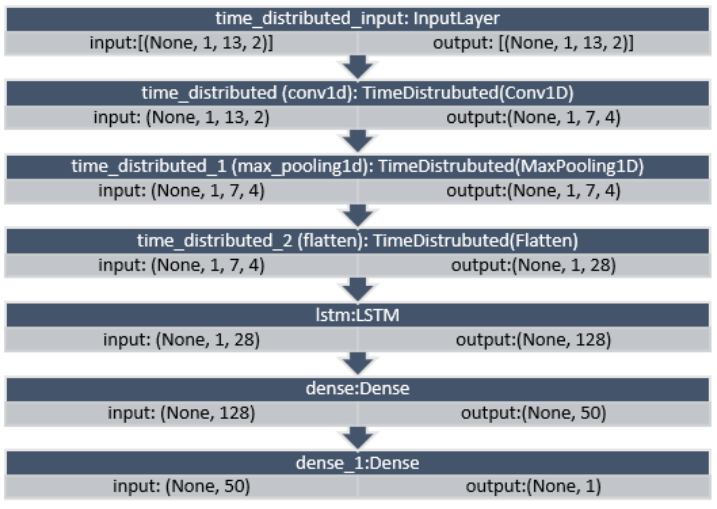
Figure 11. CNN–LSTM layers for the seventh iteration with (d0, o1) for the Beijing dataset. Figure 11. CNN – LSTM layers for the seventh iteration with (d0, o1) for the Beijing dataset. As for parameters, CNN had three layers: 1.—Conv1D with a dilation rate of 6 and group 2 with 4 filters and a kernel size of 2; 2.—the maximum pooling layer had a size of 1; 3.—the flatten layer. LSTM was composed of three consecutive layers: 1.—an entry layer (128 nodes); 2.—a hidden intermediate layer (50 nodes); and 3.—a final layer (one node). LSTM used tanh as an activation function and utilised the adaptive moment estimation (Adam) optimiser to minimise the loss function (MAE) and a batch size of (72) with (25) epochs. The LSTM arrangement was used in [20,53]. Each other parameter in each algorithm used was the default as specified by the API of scikit-learn [54].